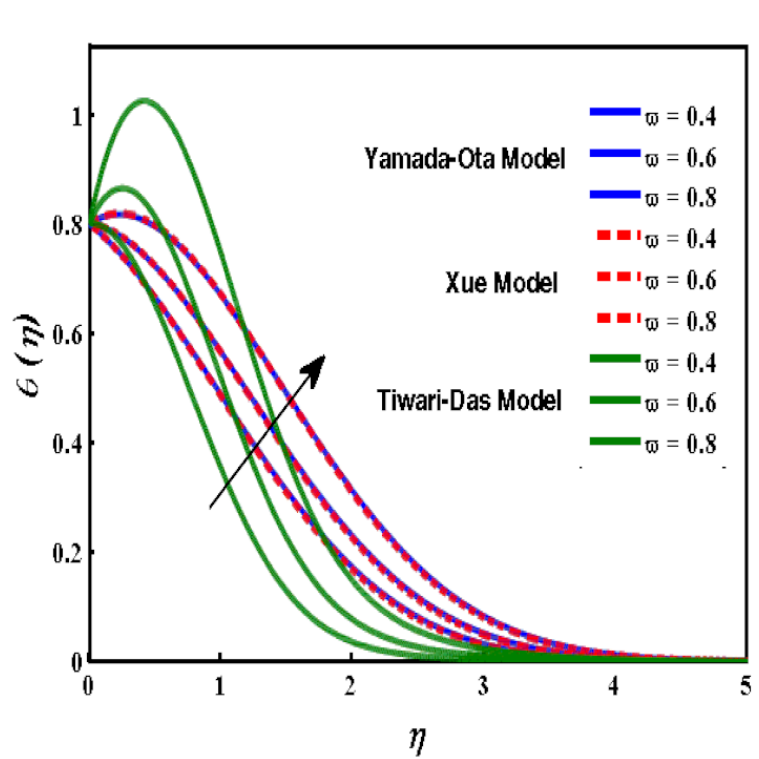
Figure 12. Influence of R d on θ ( η ) .